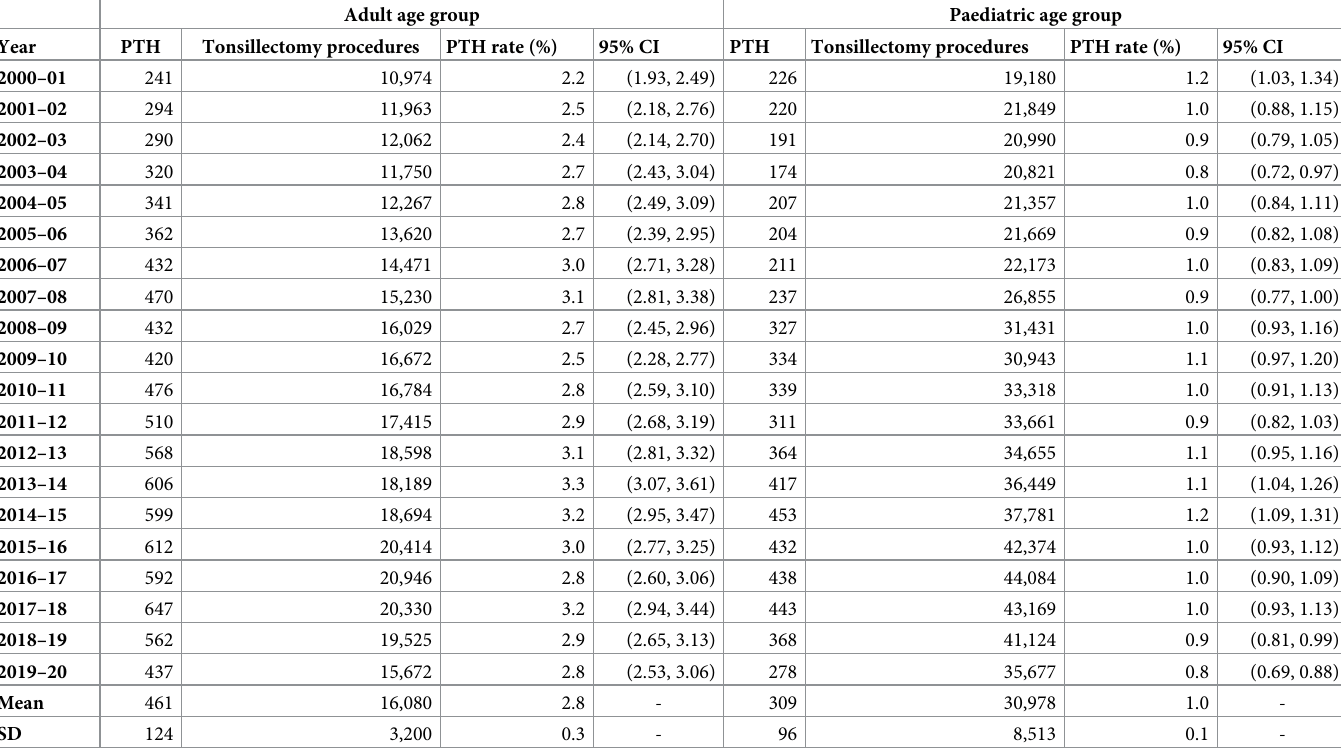
Table 1. Annual rates of post-tonsillectomy haemorrhage in Australia for the adult and paediatric population, 2000–01 to 2019–20. Adult age group Paediatric age